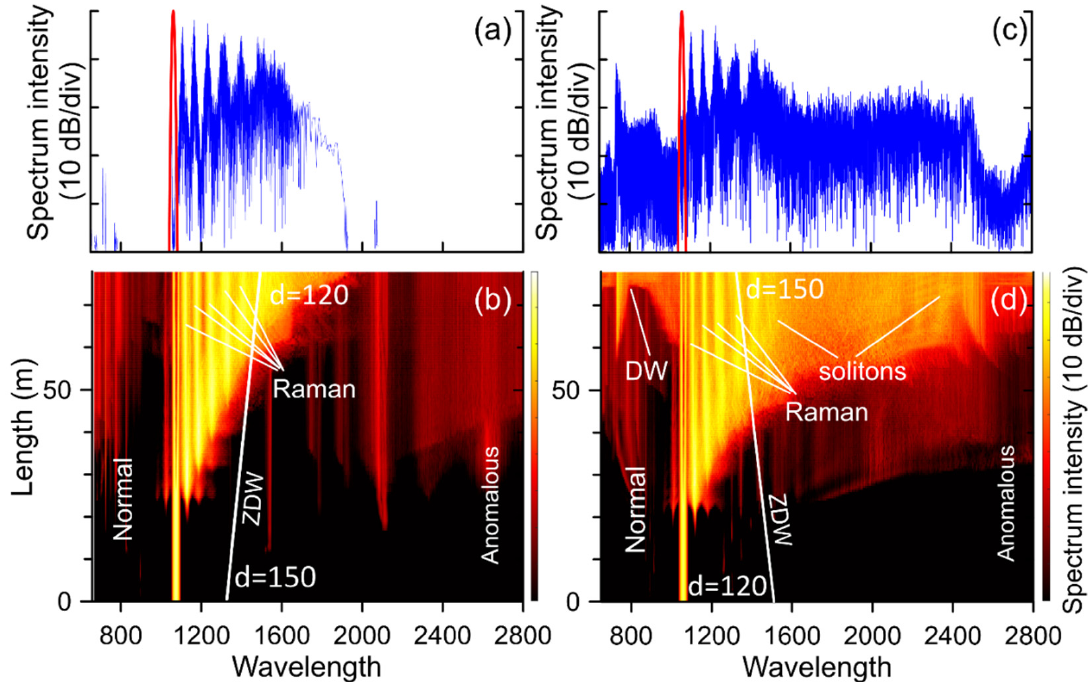
Figure 7. Spectra at the input (red) and output (blue lines) from fibers with longitudinally decreasing ( a ) and increasing ( c ) diameters. The evolution of the spectral density during the propagation of radiation through the fiber with longitudinally decreasing ( b ) and increasing ( d ) diameter.